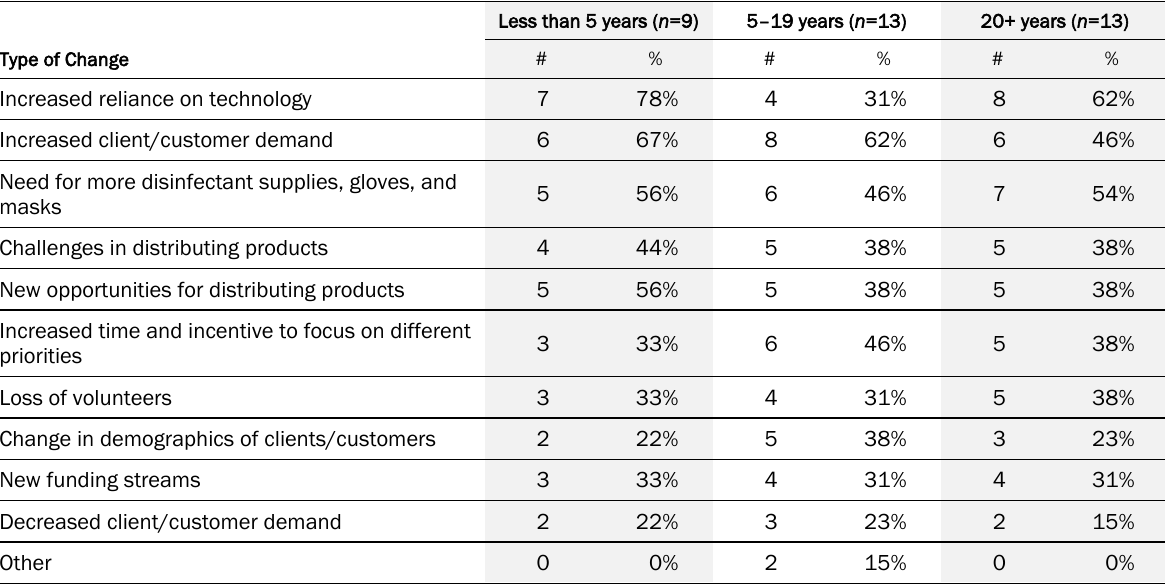
Table 5. Pandemic Impacts According to Time in